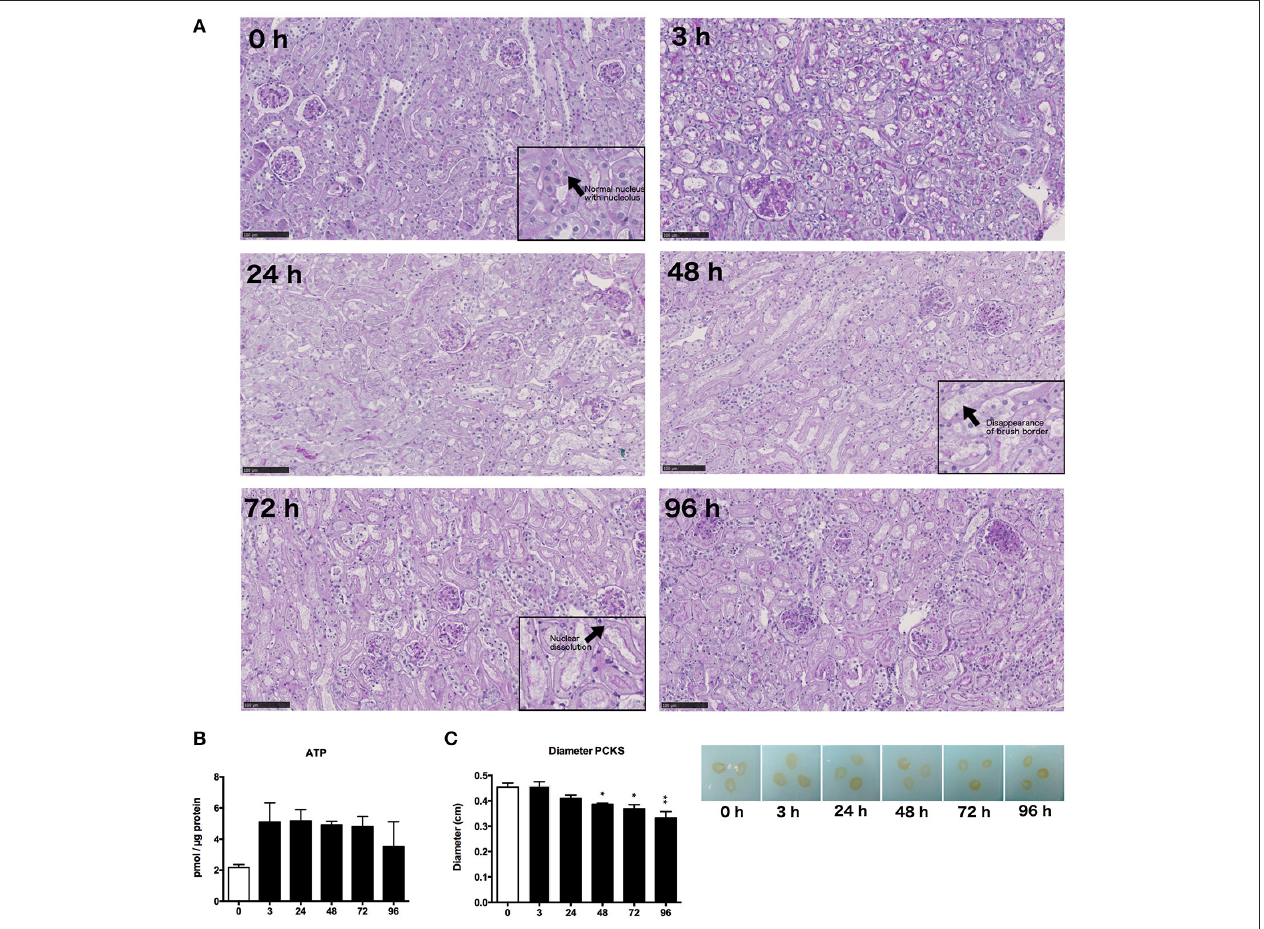
FIGURE 2 | General morphology and viability. (A) PAS staining of mPCKS during culture, magnification × 10; insets, magnification × 20, scale bar represents 100 µ m. (B) Viability measured by ATP content during incubation. (C) Slice diameter in cm during incubation. * p < 0.05, ** p < 0.001. Data is expressed as mean ( ± SEM), n = 3. PCKS, precision-cut kidney